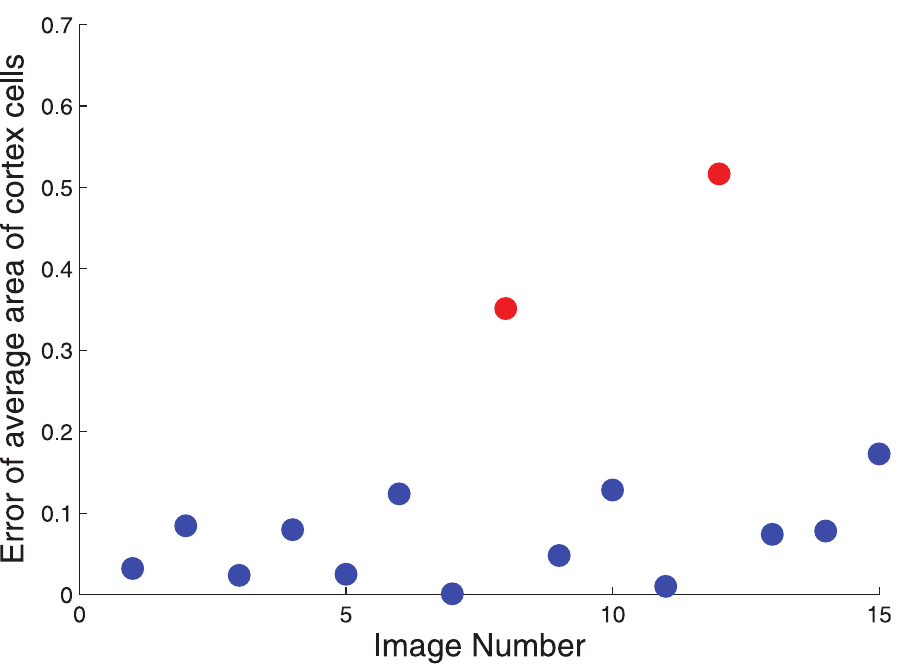
Fig 12. Percentage errors in evaluating average area of cortex cells. 13 of the 15 images produce a much lower degree of error in average cortex cell area calculation. The two red markers of significant error correspond to poor quality (i.e., damaged) root